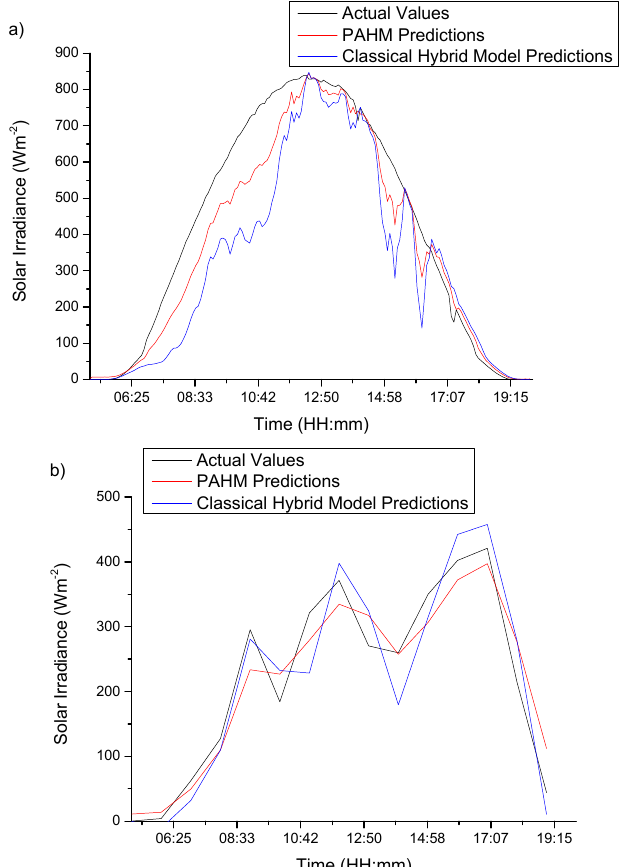
Figure 8. Comparison of the performances of the hybrid models ( a ) 5-min forecasts ( b ) 60-min forecast.